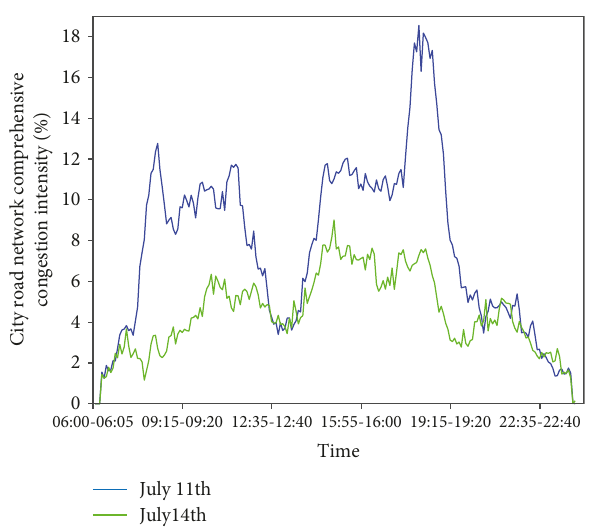
Figure 6: City road network comprehensive